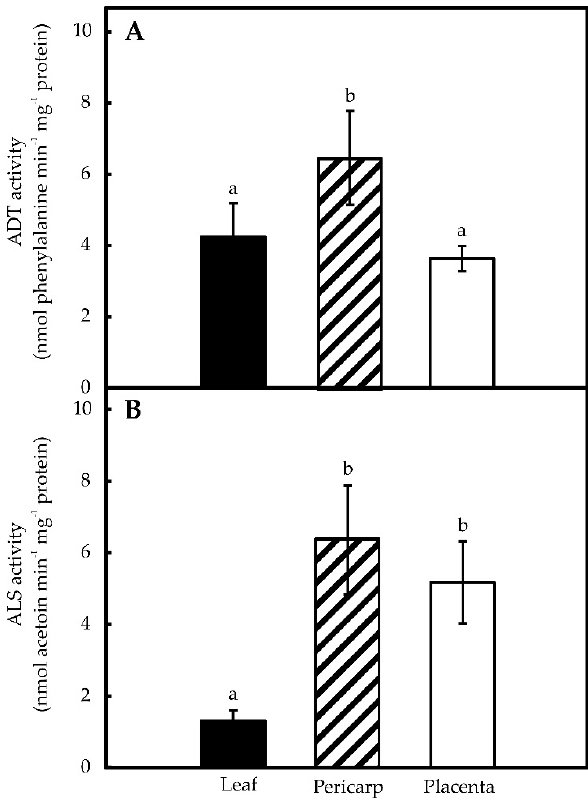
Figure 2. Arogenate dehydratase (ADT) ( A ) and acetolactate synthase (ALS) ( B ) specific activities in leaves, pericarps and placentas from C. chinense . Data represent mean ± standard deviation (S.D.) of three independent experiments with three replicates. Bars labeled with different letters are significantly different (Tukey’s test, α = 0.05).